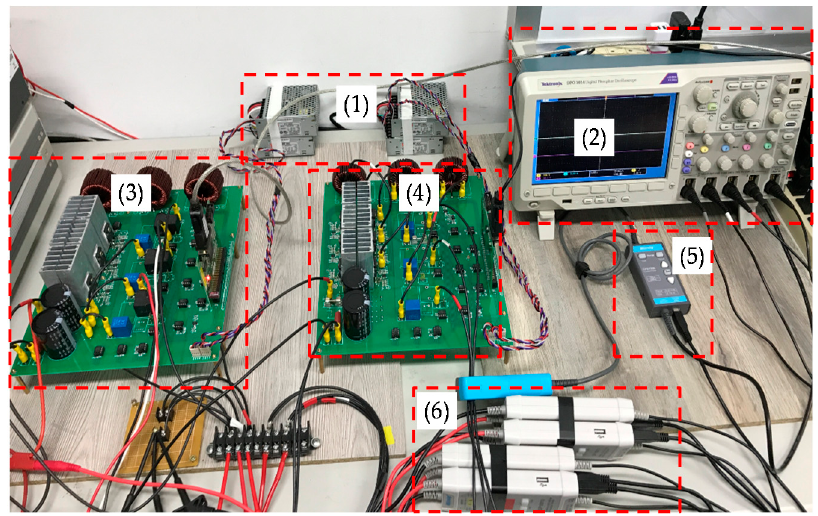
Figure 29. Photo of the constructed VRFB PCS hardware and the experimental platform.